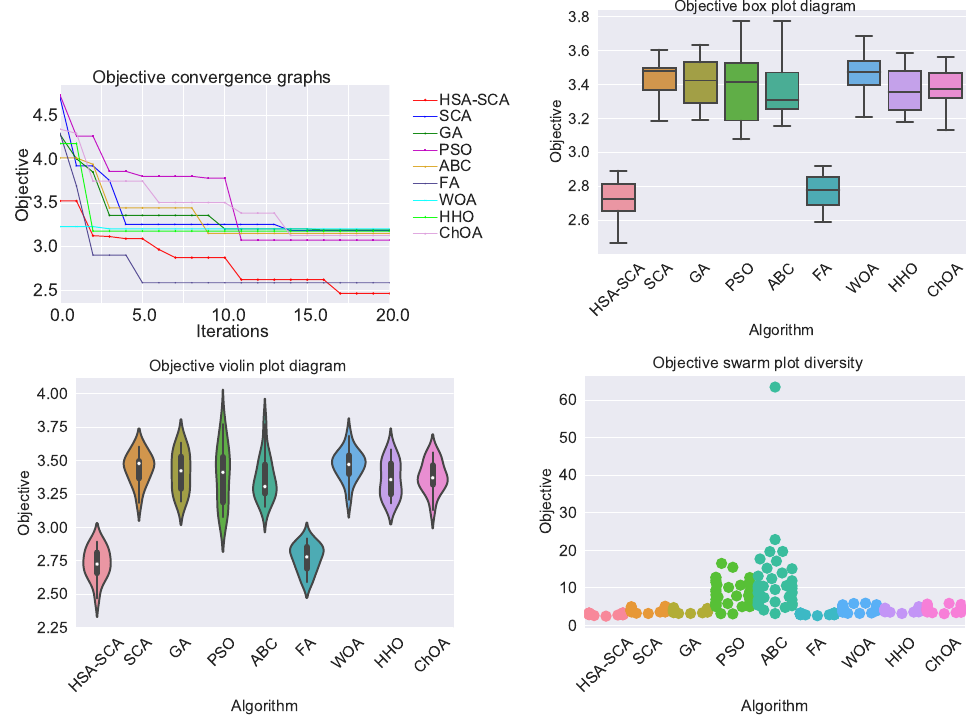
Figure 2. Visualized XGBoost results for all nine metaheuristics in terms of the convergence, box plot, violin diagrams, and swarm diversity plots for the fitness function (MSE).